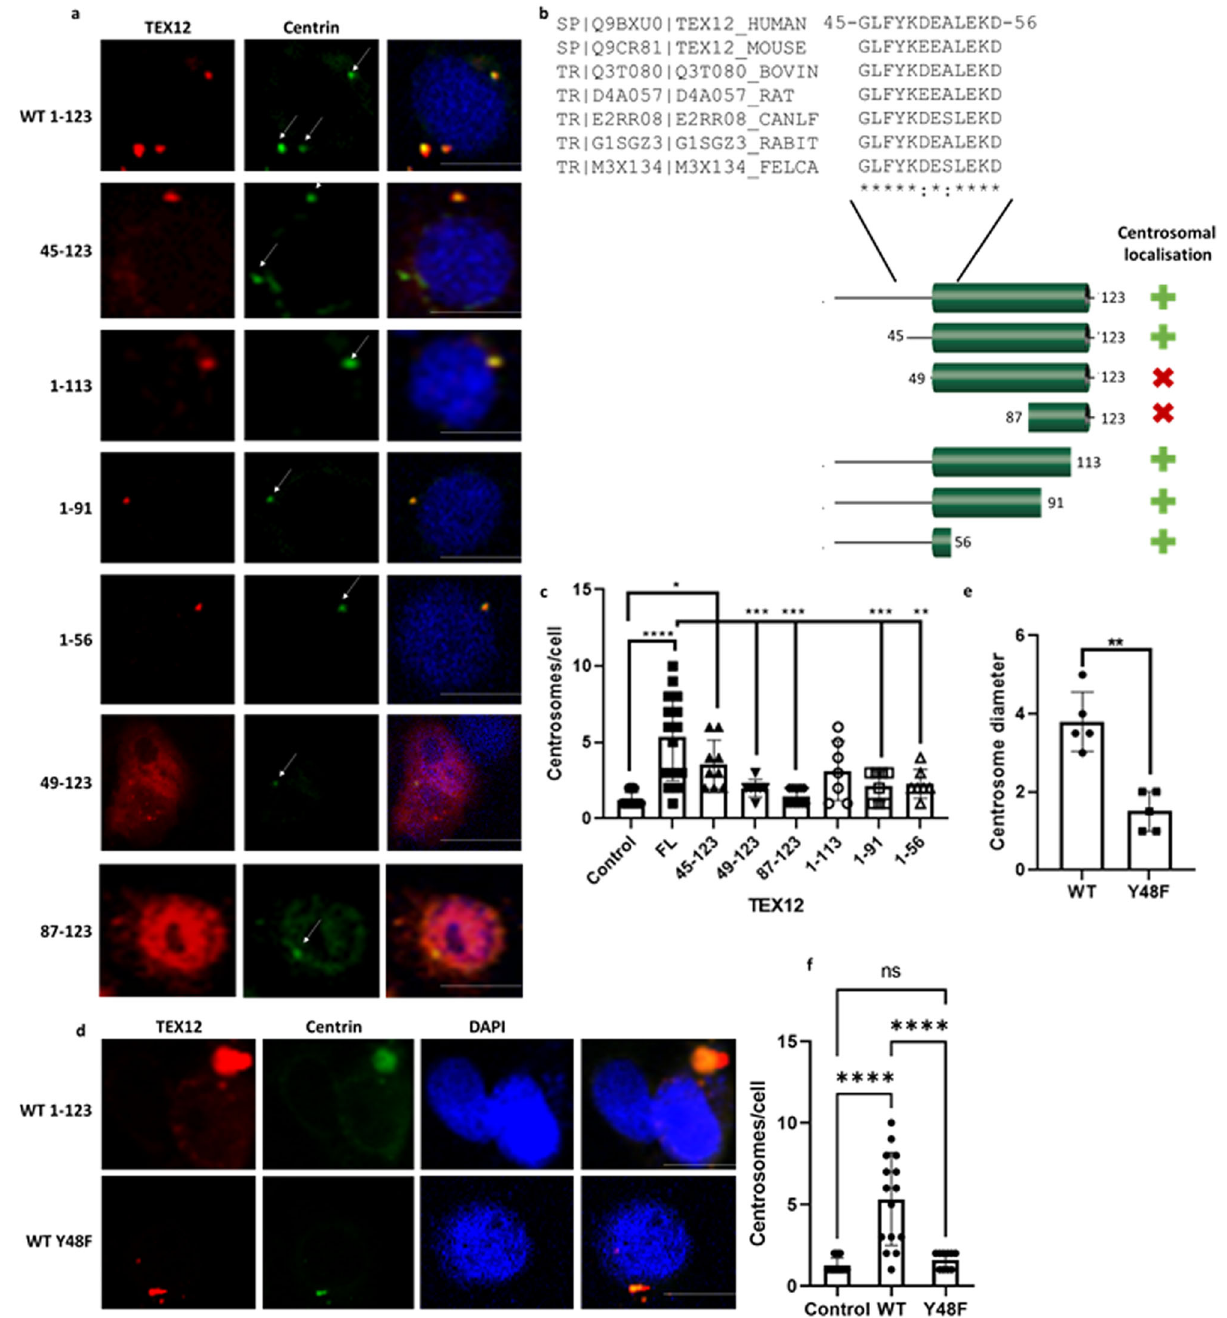
Fig. 5 G45-D56 region of TEX12 regulates centrosomal localisation and function. a COS-7 cells transfected with TEX12 plasmids as indicated and stained with TEX12 (Abcam ab122455) (red) and centrin (green). Centrosomes are indicated with white arrows. Bar = 20 µ m. b Diagram of TEX12 domain structure and comparison of region conservation across species. c Number of centrosomes per cell in COS-7 cells following transfection with indicated TEX12 plasmids. * p < 0.05; ** p < 0.001; *** p < 0.005. Error bars represent standard deviation. Each data point represents an individual cell, between 5 and 15 cells per transfection were measured over three independent experiments. d COS-7 cells were transfected with wild-type (WT) and Y48F TEX12 mutant as indicated. Bar = 20 µ m. e Centrosome size in COS-7 cells 96 h after transfection with WT TEX12 ( n = 5) or Y48F TEX12 ( n = 5) was quanti fi ed. ** p < 0.01. Error bars represent standard deviation across three independent experiments. f Number of centrosomes per cell in COS-7 cells following transfection with WT or Y48F TEX12 **** p < 0.001. Error bars represent standard deviation. Each data point represents an individual cell, between 5 and 15 cells per transfection were measured over three independent experiments, this is an expansion of e coiled-coil protein constituent, such as TEX12, may underlie their near the microtubule organizing center (MTOC) in mouse close functional relationship. TEX12 localisation to centrosomes has spermatocytes 57 . This dramatic chromosome choreography suggests a requirement for close functional integration between the SC and similarities with previous observations in which SC components were MTOCs. Given that both the SC and MTOC are coiled-coil rich, a found to localise to MTOCs/spindle-pole bodies, including 6C6 in structural connection between the SC and MTOCs through a shared plants 58 , and Sme4 in Sordariales 59,60 . However, this is the fi rst report